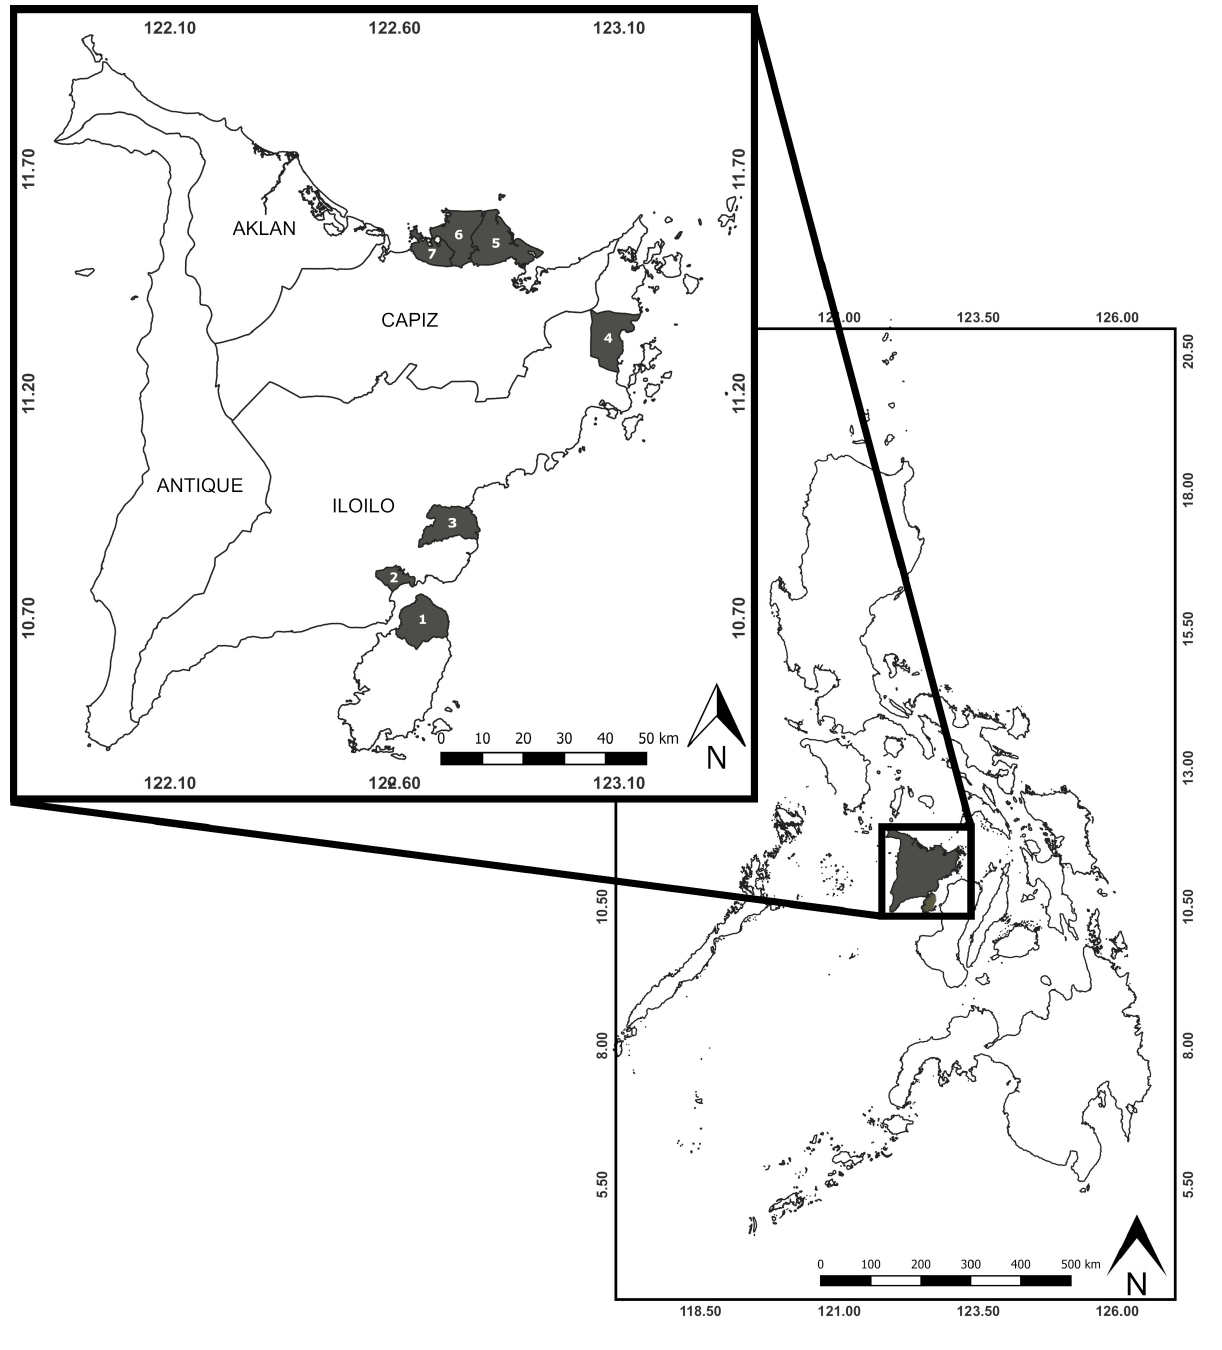
coastal zone of Panay or Guimaras islands; (2) they were sea- or estuary-facing (breached pond dikes immediately adjacent to these water bodies), i.e., they had direct hydrological access for moderate-distance propagule dispersal from adjacent established